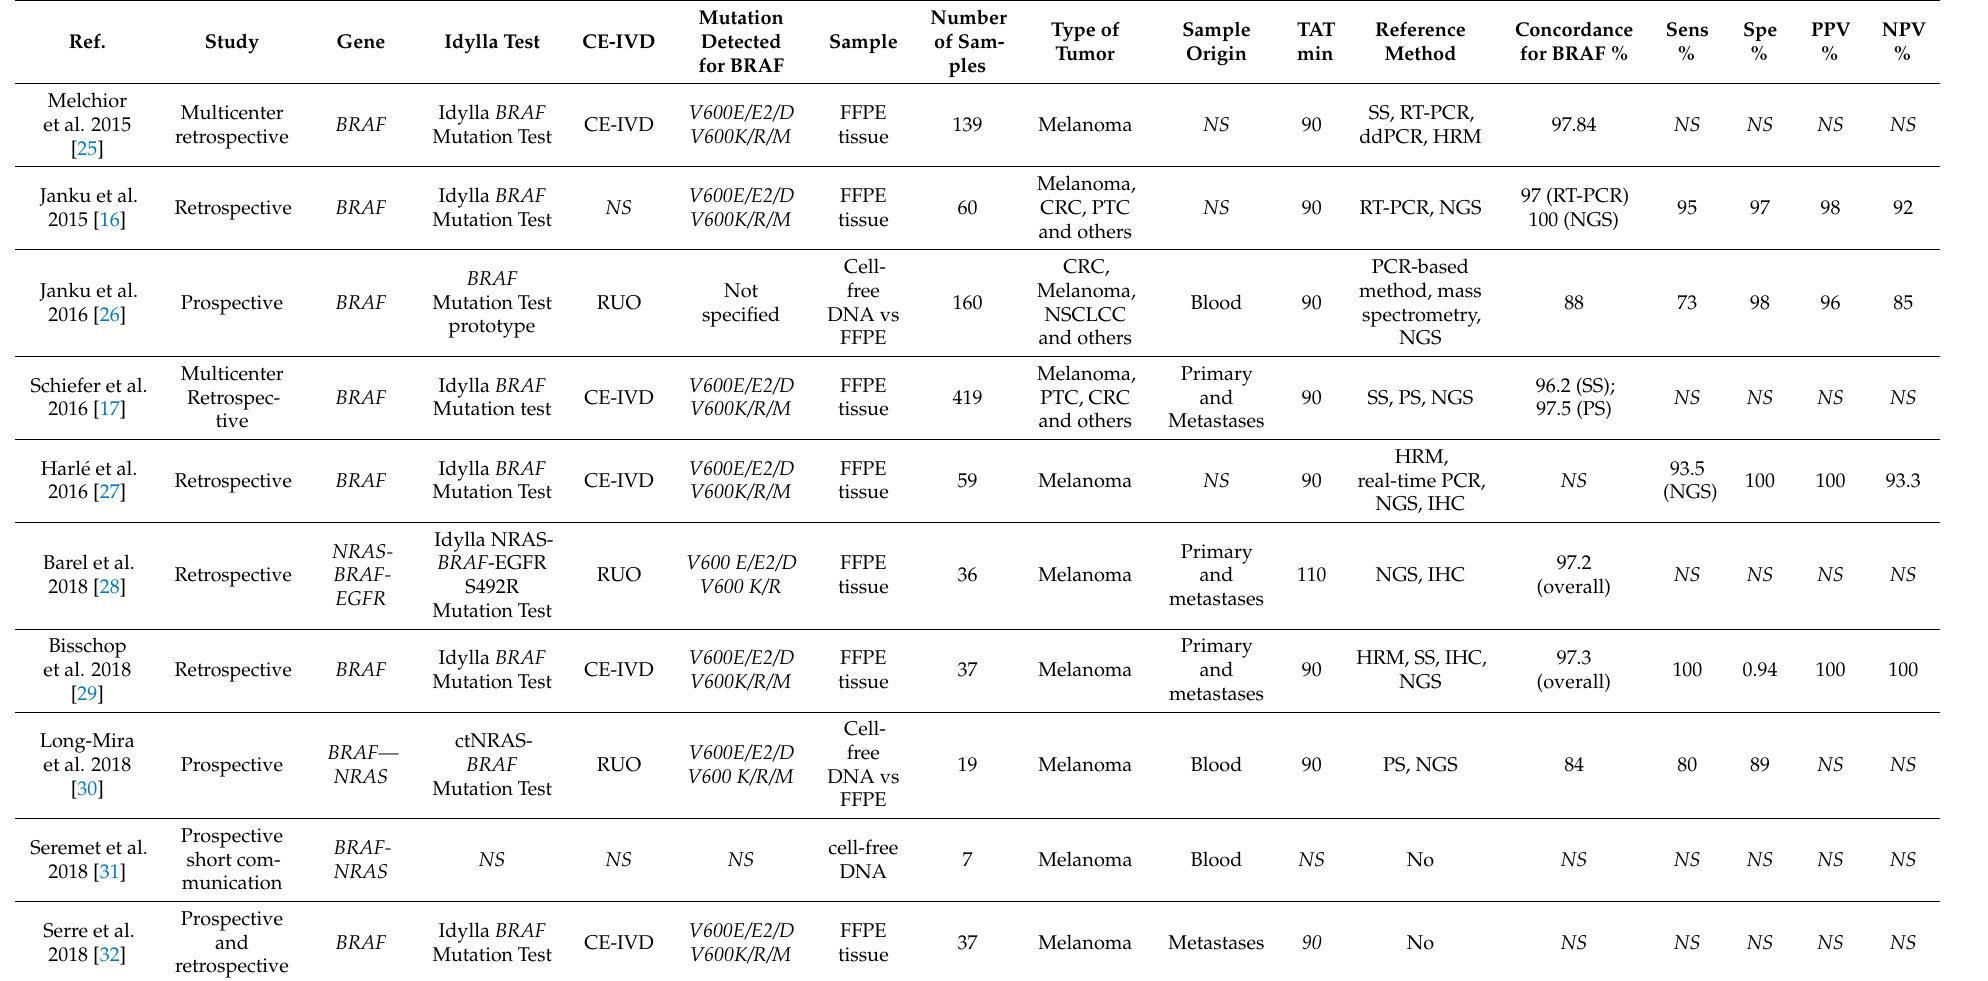
Table 5. Literature review of studies on the performance of Idylla for BRAF detection in melanoma.